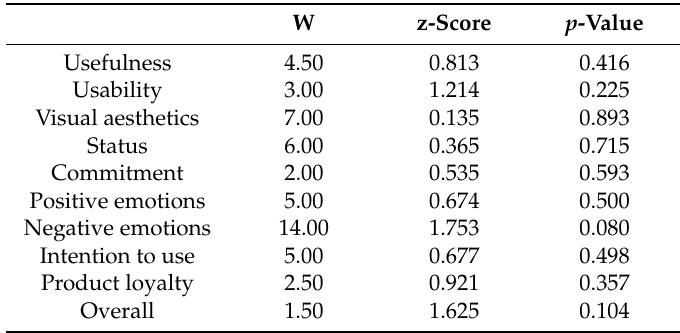
Table 15. Test for correlation between design type and meCUE scores.